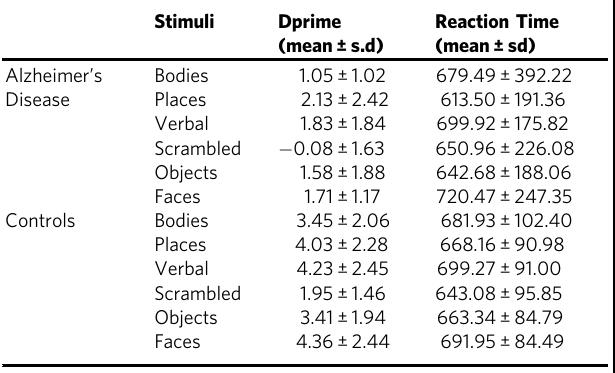
Table 3 Descriptive statistics for the behavioural